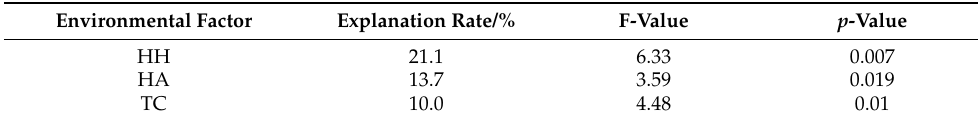
Table 3. Monte Carlo significance test of environmental factors in relation to the RDA models. Tree layer cover (TC), herbage layer abundance (HA), and herb layer height (HH).